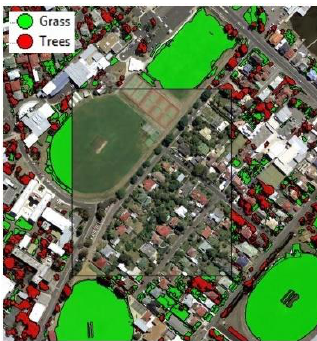
Figure 5. Removing ground truthing of trees and grass from the test region. Figure 8. Resizing the classified objects, a) Image showing segments before merging b) Image showing segments after merging c) Image showing result of resizing of merged segments using pixel-wise object resizing (growing and